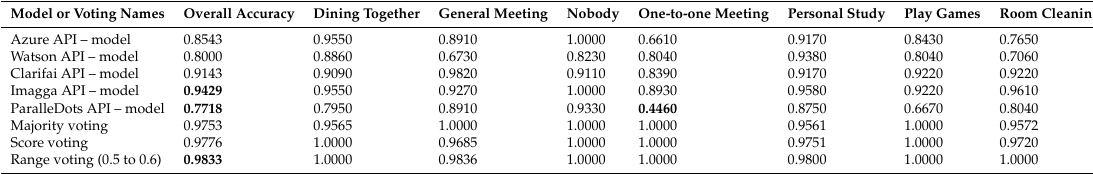
Table 4. The accuracy results of each cognitive API-based model and three voting